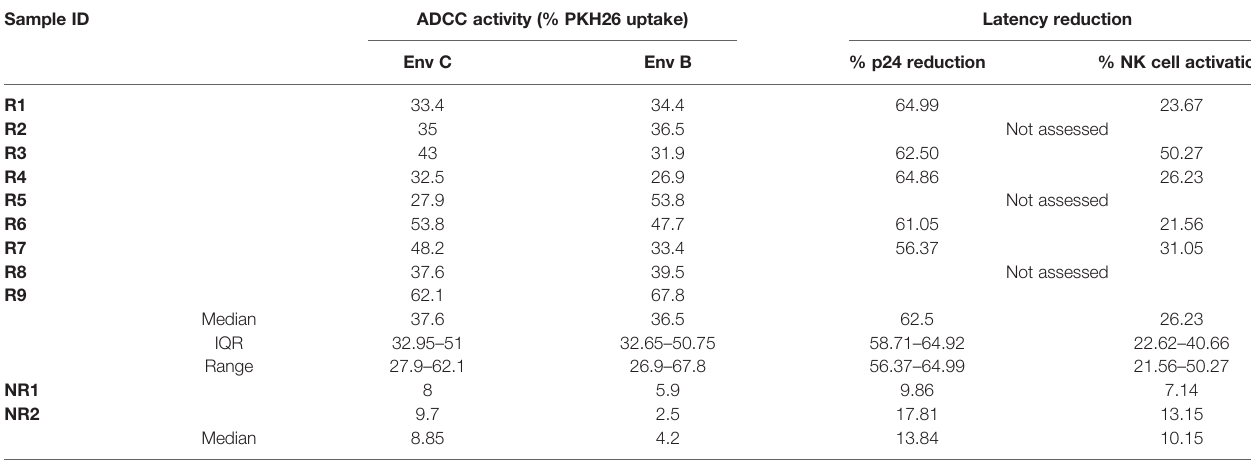
TABLE 1 | Characteristics of in-vitro -generated HIV-speci fi c antibodies. Sample